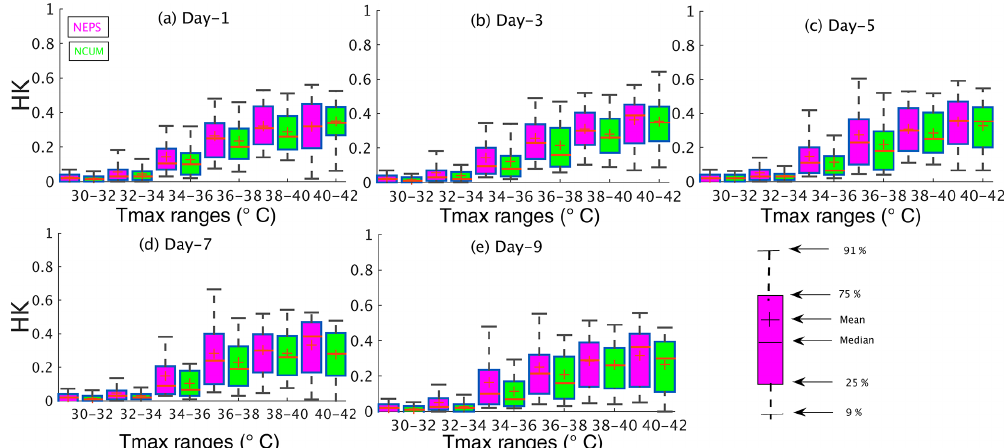
Figure 9. Box plots (a–e) for Hanssen and Kuipers (HK) scores for different temperature ranges ( T max ) NCUM and NEPS from March to May 2016 (NCUM stands for NCMRWF unified model and NEPS stands for NCMRWF ensemble prediction system). HK score values are higher in NEPS forecasts, particularly at high temperature ranges (>36 ◦ C), and for all lead times compared to NCUM forecasts, suggesting improved performance of NEPS at higher temperature